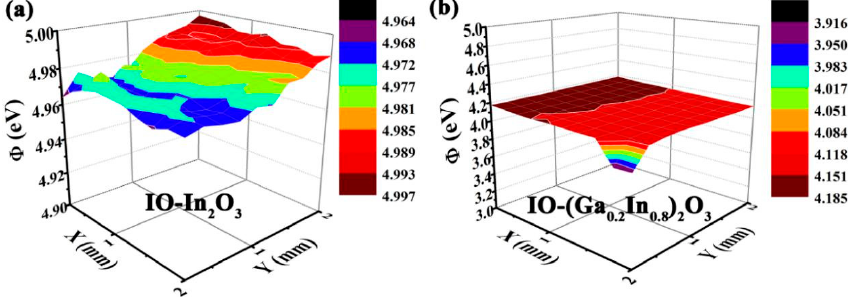
Figure 3. ( a , b ) work function area scan recorded for IO-(Ga x In 1-x ) 2 O 3 (x = 0 and 0.2) samples via Kelvin probe